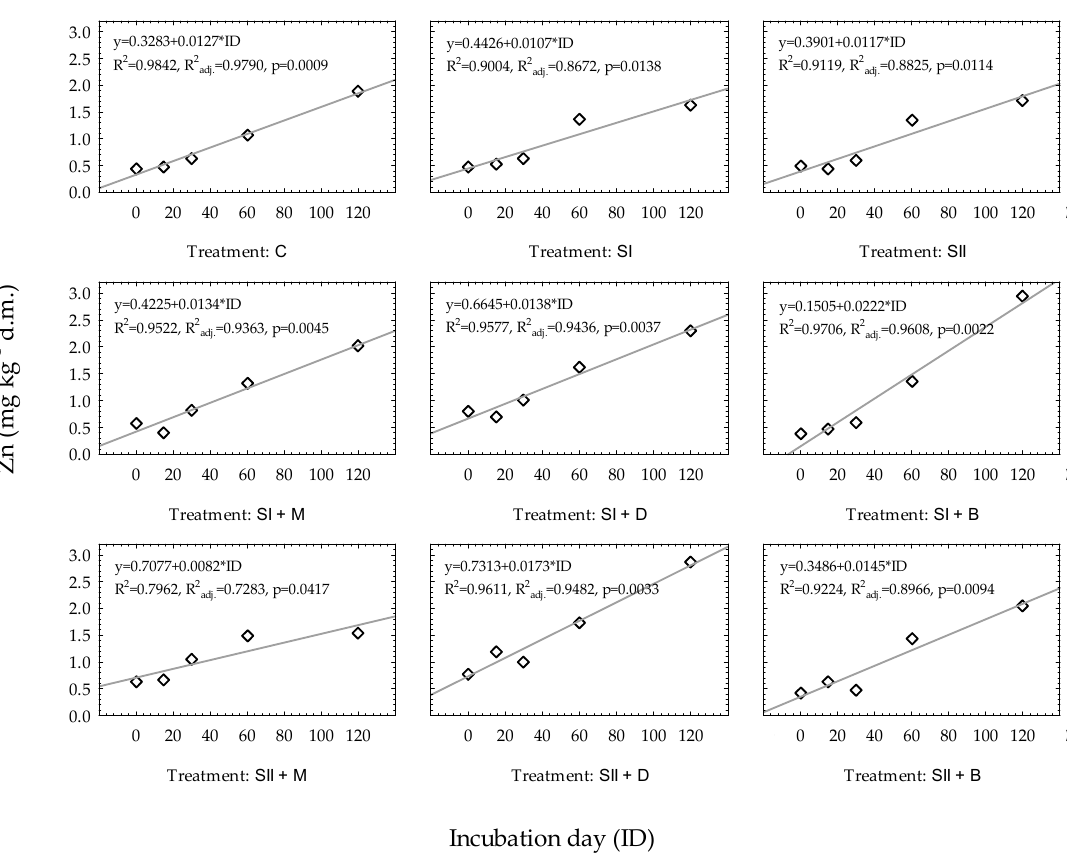
Figure 2. Linear regression models of Zn changes over time based on experimental treatments in very light soil. Regression equations are presented only when p ≤ 0.05. * constitute a multiplication mark.